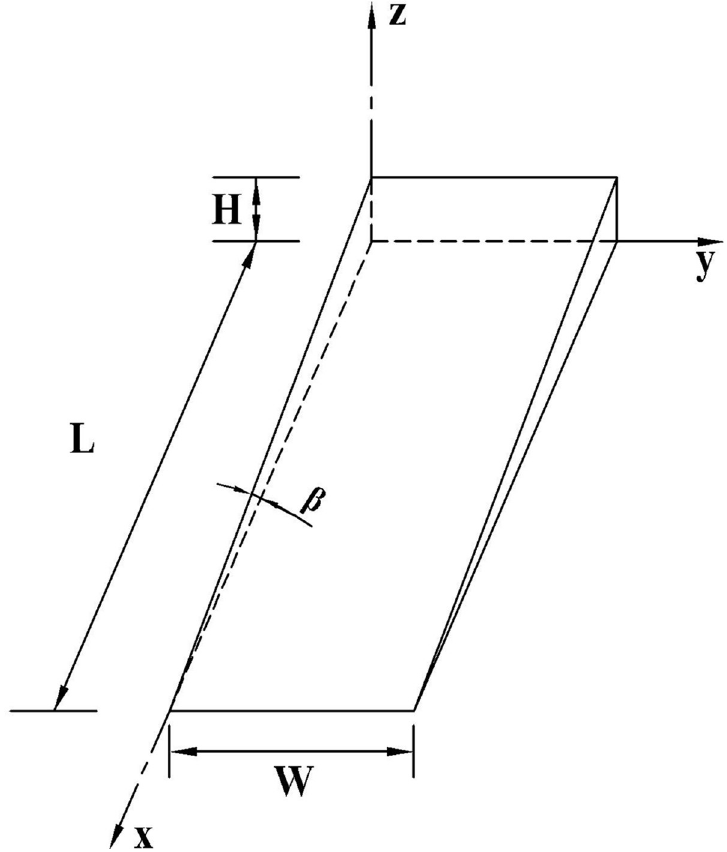
Fig 4. Road surface water accumulation Model